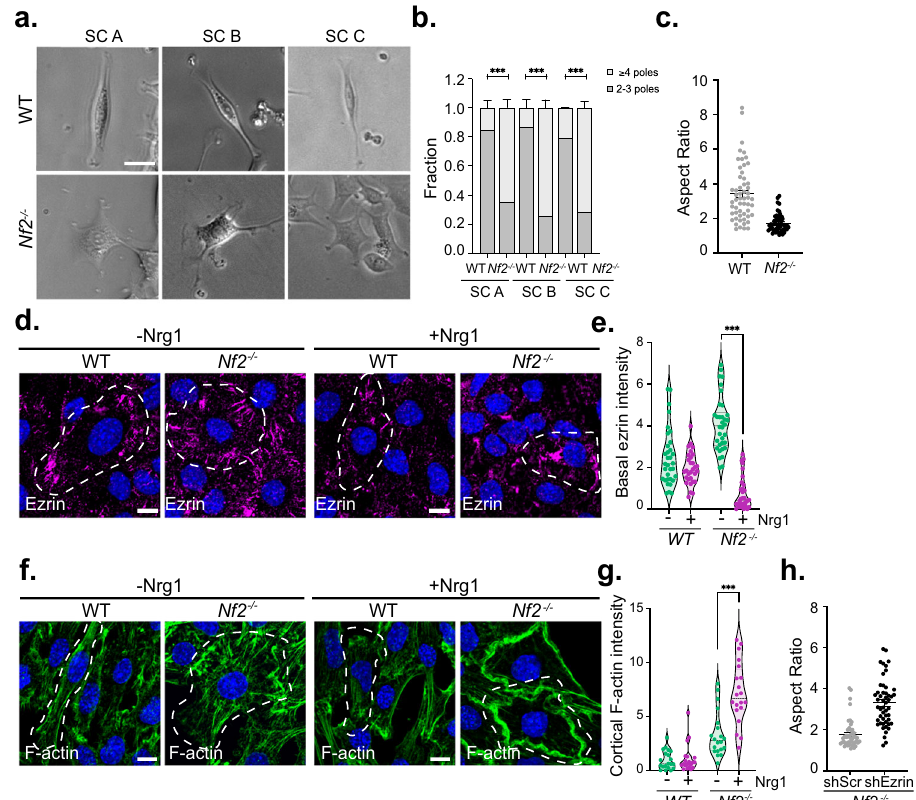
Fig. 1 | Nf2-de fi cient Schwann cells exhibit enhanced multipolarity and exag- gerated cytoskeletal responses to Nrg1 availability. a , b Representative phase contrast images and quantitation of polarity in three independently generated Nf2 − / − and control parental Nf2 fl ox / fl ox (WT) SC lines. Data represent the fraction of cells containing 2 – 3 poles or ≥ 4 poles. n =123 (WT SC A), n =420 ( Nf2 − / − SC A), n =127 (WT SC B), n =85 ( Nf2 − / − SC B), n =377 (WT SC C), n =633 ( Nf2 − / − SC C). c Aspect ratio (length of long axis: length of short axis) in Nf2 − / − and WT SC lines. n =55 (WT) or n =50 ( Nf2 − / − ) cells. d Confocal images depicting ezrin localization in WT and Nf2 − / − SCs with and without Nrg1 stimulation (10ng/ml Nrg1, 10min). Dashed lines drawn according to F-actin distribution outline individual SCs to highlight theiraspect ratio. e Violin plot depicting basal ezrin intensity in WT and Nf2 − / − SCs with and without Nrg1. The area of ezrin-containing microvilli was measuredatthe basalcellsurface(see methods)inthresholdedimagesofROIsat